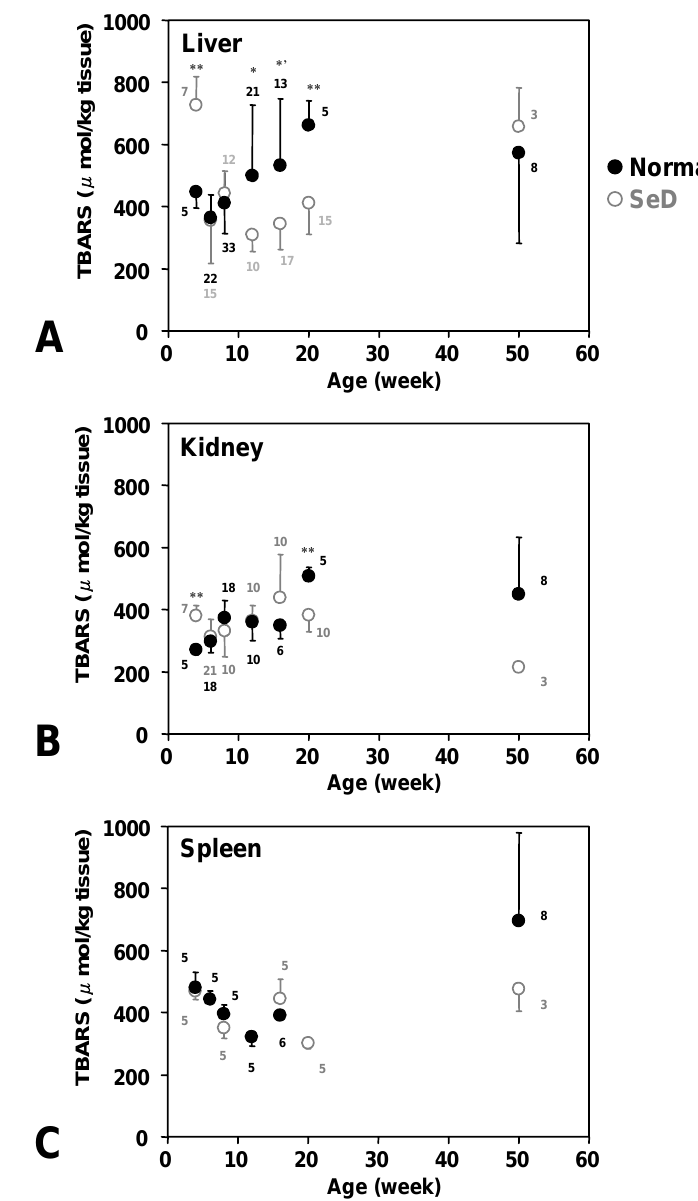
Figure 6. Dependence of TBARS levels in (A) liver, (B) kidney, and (C) spleen of normal and SeD rats on the age of rats. Gray open and black closed circles were indicated values of SeD and normal groups. Values are indicated as the mean ± SD. Numbers indicated in the figures are the number of samples measured. * , *’ , and ** indicate significant differences between normal and SeD groups at p < 0.05, p < 0.01, and p < 0.001,